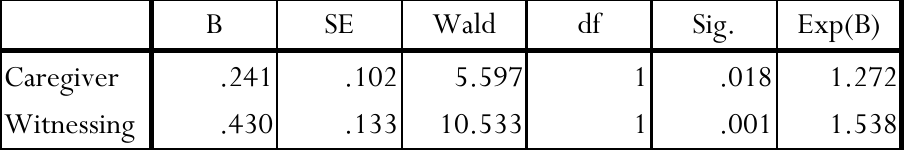
Table 12: Cox Regression of Number of Victimizations on Onset of Substance Use